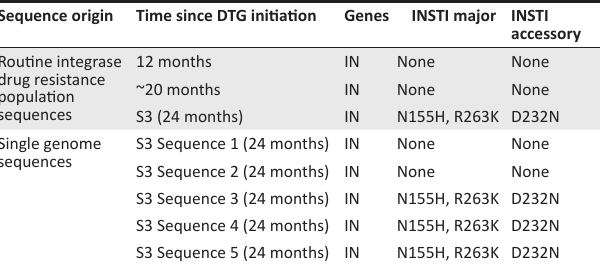
TABLE 3: Integrase population and single genome sequences indicating associated drug resistance mutations.